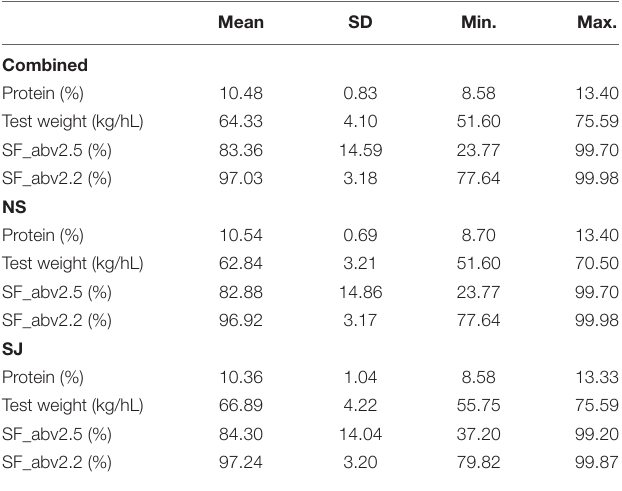
TABLE 2 | Summary description of traits for overall data and by breeding